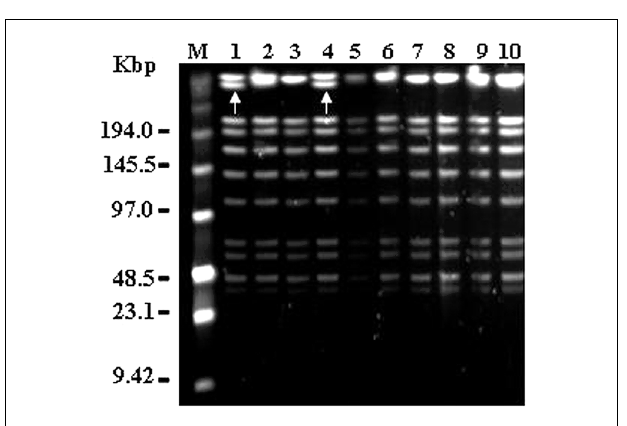
FIGURE 2 | Frequency of phage attacks of the strains contained in the standard Crescenza blends ST020 (ST1A and ST1B), ST022 (ST2C and ST2D), and ST024 (ST3E and ST3F) as well as the phage-hardened blend ST020R (BIM5 and ST1B). Each strain was grown in milk or in milk with